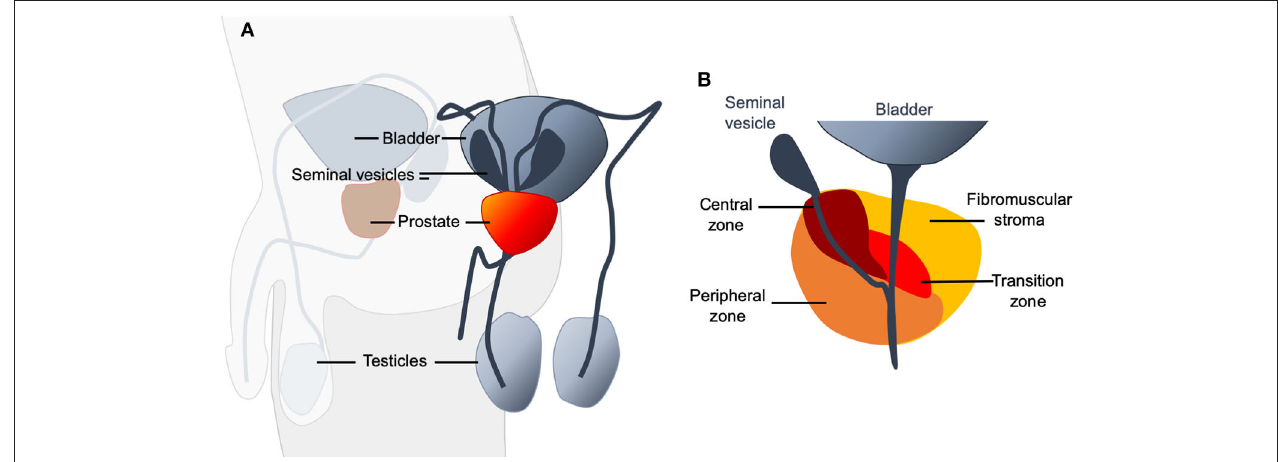
FIGURE 1 | (A) Schematic representation of the location of the prostate (shown in red) in the male urogenital system. It is an organ of fibro-muscular and glandular nature and has the shape of an inverted pyramid. (B) Four zones can be distinguished in the prostate: The anterior zone or fibromuscular stroma, the peripheral zone, the central zone, and the transitional zone. The anterior zone is of fibromuscular nature, a thick sheet of compact connective and muscular tissue that covers the entire anterior surface of the prostate. It surrounds the proximal urethra at the level of the bladder neck, where it joins the internal sphincter and detrusor muscle in which it originates. It occupies almost a third of the total volume of the prostate and does not contain glands. It does not participate in any pathology of the prostate. The peripheral zone is of endodermal origin and is the largest anatomical region of the glandular prostate. The central zone is the smallest of the regions of the glandular prostate. It represents between 20 and 25% of its mass and is crossed by the ejaculatory ducts. The fourth zone, the transitional zone, has a mesodermal origin, formed by a small group of ducts closely related to the proximal urethra. These ducts represent 5% of the glandular prostate mass.